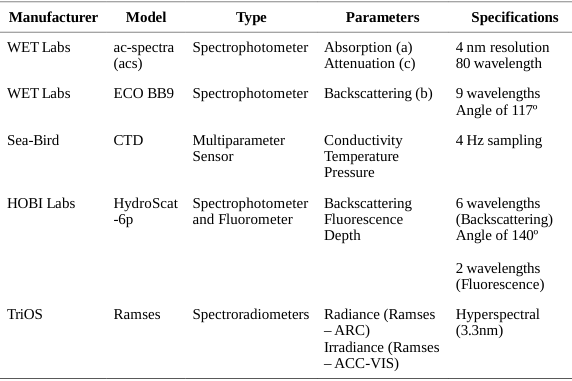
Table 1: Summary of the five sensor utilized in our case Aiming the capability of performing multivariate analysis to explore the correlations between the collected parameters, at each field campaign, the equipment set must be used to guarantee the existence of measurements in the same collecting scenario, considering the spatial and temporal